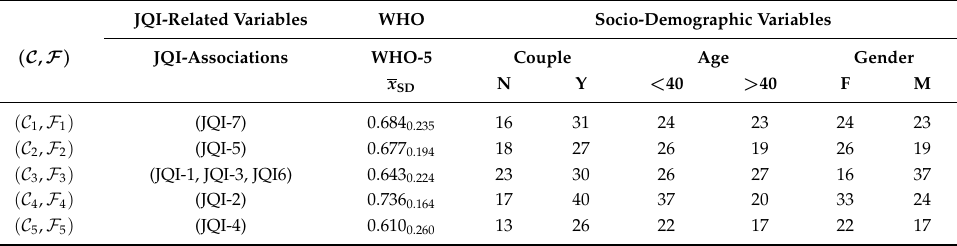
Table 4. Statistical characteristics of the five groups ( C , F ) : JQI-associations, mean and standard deviation for the WHO index per cluster ( x SD ), number of participants without and with a couple (N and Y), number of accountants younger and older than 40 years ( < 40 and > 40) and number of females and males (F and